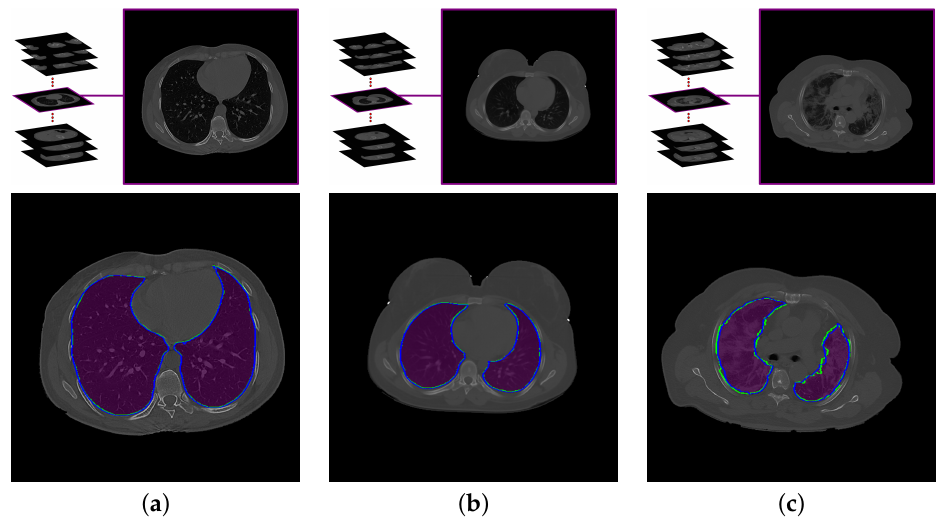
Figure 3. An illustrative example of the proposed segmentation approach for ( a ) healthy/mild, ( b ) moderate, and ( c ) severe COVID-19 infections. Note that the blue (green) border represents our segmentation (ground